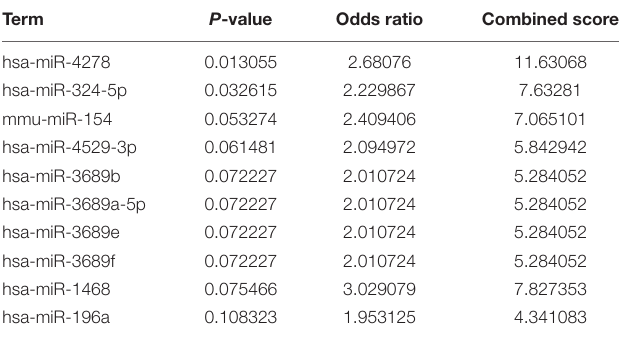
TABLE 5 | The potential miRNA targets of CLEC4s based on Enrichr.